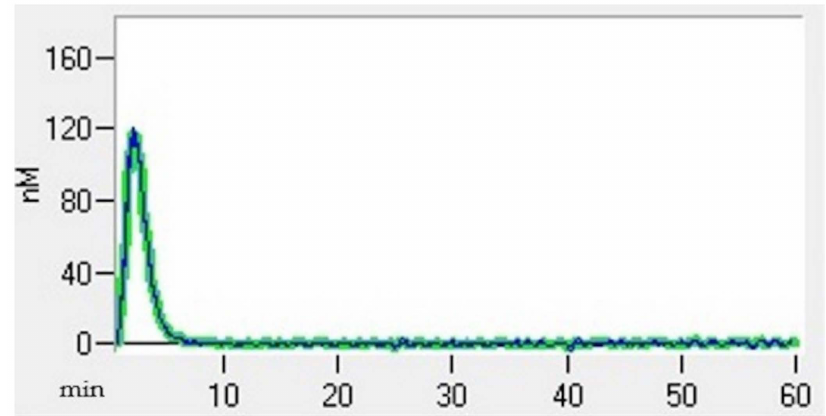
Figure 2. Thrombin generation curve of a healthy